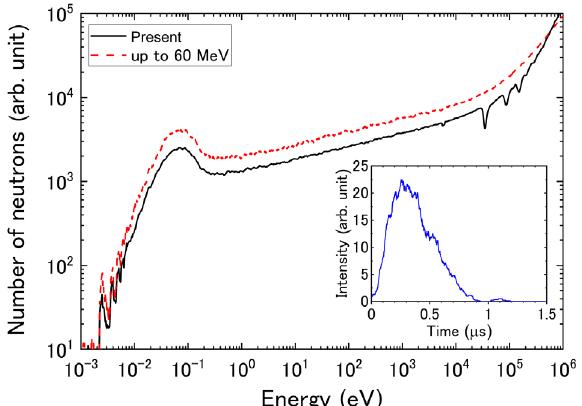
8. Energy spectra of neutrons at the bottom (exit) of the moderator simulated using PHITS for the present experiment (solid line) and for the high-repetition laser system (dashed line) discussed in Sec. V. The inset shows the pulse duration of 10-eV neutrons obtained with the incidence of 60-MeV